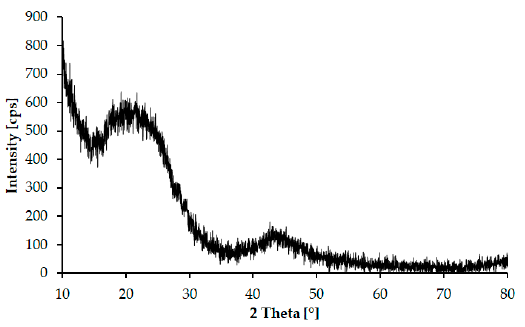
Figure 4. XRD pattern of Ultem 9085 solid residue obtained after thermal degradation.